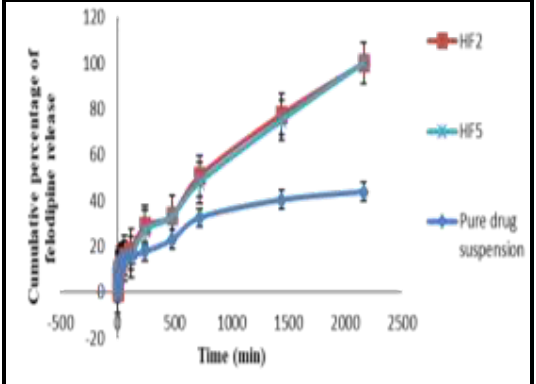
Figure 2. In vitro felodipine release profile from LPHNs formulations HF2,HF5 and the pure drug at HCl buffer pH 1.2 + 0.3 % polysorbate 80 solutions, the values of mean ±SD